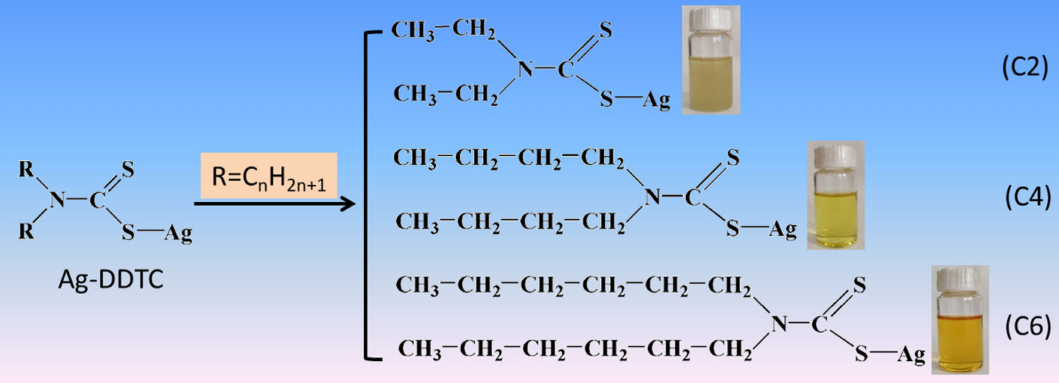
Figure 1. Structural diagram of the single-source